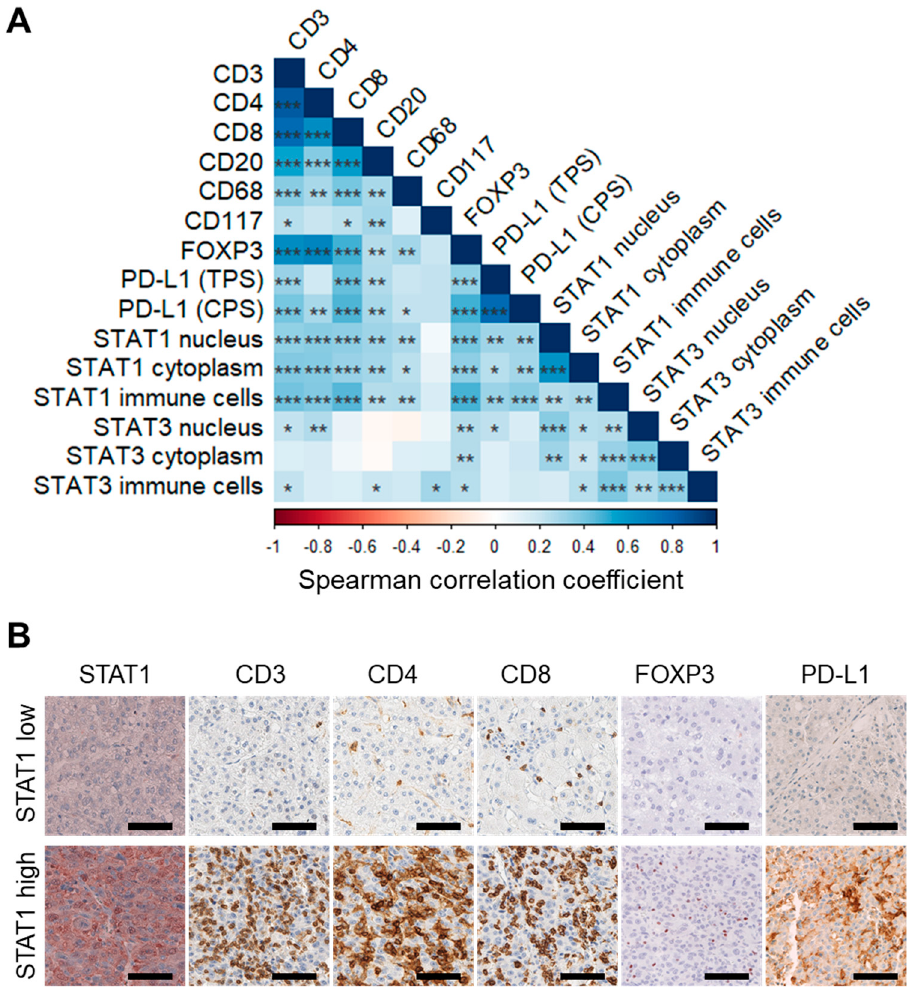
Figure 4. Correlation of STAT1 and STAT3 expression with immune cell infiltration in HCC. ( A ) Correlation matrix of immune cell infiltrates and immunohistochemical STAT1 or STAT3 expression in HCC tumor tissue samples. Red color indicates negative correlation, whereas blue color indicates positive correlation. Darker coloration indicates a higher Spearman correlation coefficient and asterisk denotes the level of significance. Spearman p -value: * <0.05; ** <0.01; *** <0.001. ( B ) Exemplary HCC tumor tissues with low or high immunohistochemical reaction against STAT1 are shown, respectively. The corresponding immune cell infiltrate stained for CD3, CD4, CD8, FOXP3, and PD-L1 protein expression in the same tumor dot is shown as indicated. Scale bar: 100 μ m.